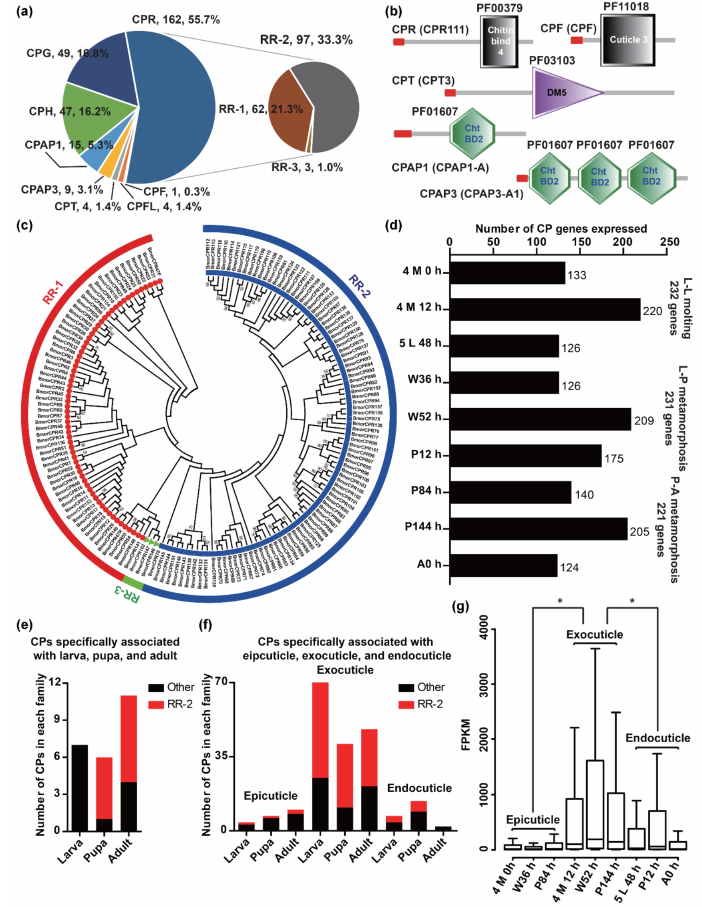
Figure 3. Identification, classification, and expression analyses of CPs in B. mori . ( a ) The distribution of CPs in each family. ( b ) Pfam domains of CPs in B . mori . The red rectangle represents the signal peptide. The CPs in CPR, CPF, CPT, and CPAP1 and CPAP3 protein families contain the domains of Chitin bind 4 (PF00379), Cuticle 3 (PF11018), DM5 (PF03103), and Cht BD2 (PF01607), respectively. ( c ) Phylogenetic relationships of CPs in the CPR protein family. A total of 162 CPs of the CPR protein family were classified into three subfamilies, 62 RR-1 (red circles), 97 RR-2 (blue squares), and three RR-3 (green triangle). ( d ) The number of CP genes expressed in our transcriptome. ( e ) The number of CPs specifically associated with larval, pupal, and adult cuticles. The red and black columns represent the CP families of RR-2 and others. ( f ) The number of CPs specifically associated with epicuticle, exocuticle, and endocuticle. The red and black columns represent the CP families of RR-2 and others. ( g ) The expression level of CP genes expressed in each developmental stage. The p -value was calculated by the Wilcoxon rank sum test and less than 0.05 was considered statistically significant. The asterisk indicated a significant difference between the two